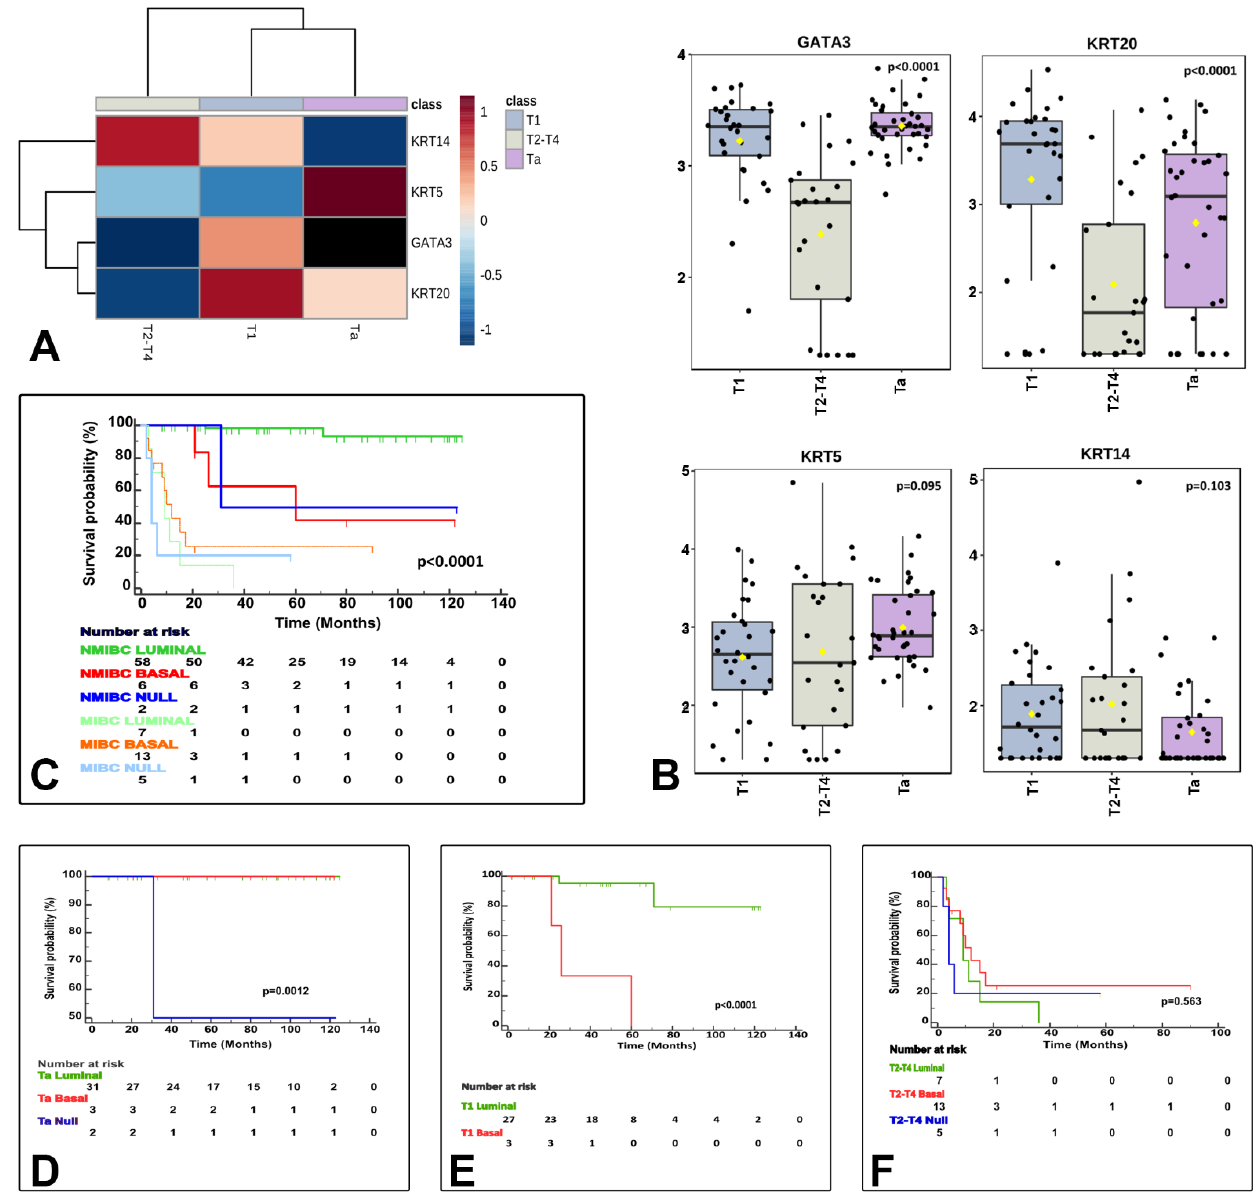
Figure 4. The three identified molecular subtypes correlate with tumor stage related features. The heatmap shows differentially expressed luminal and basal markers by stage category ( A ). Box and whisker plots of the normalized values (mean ± SD) illustrate the expression of GATA3, KRT20, KRT5, and KRT14 by stage category (ANOVA test) ( B ). The Kaplan–Meier plots identified differences for cancer specific survival (CSS) by clinically meaningful categories (NMIBC vs. MIBC) ( C ) and separately for Ta ( D ), T1 ( E ), and T2 − 4 ( F ) stage categories.